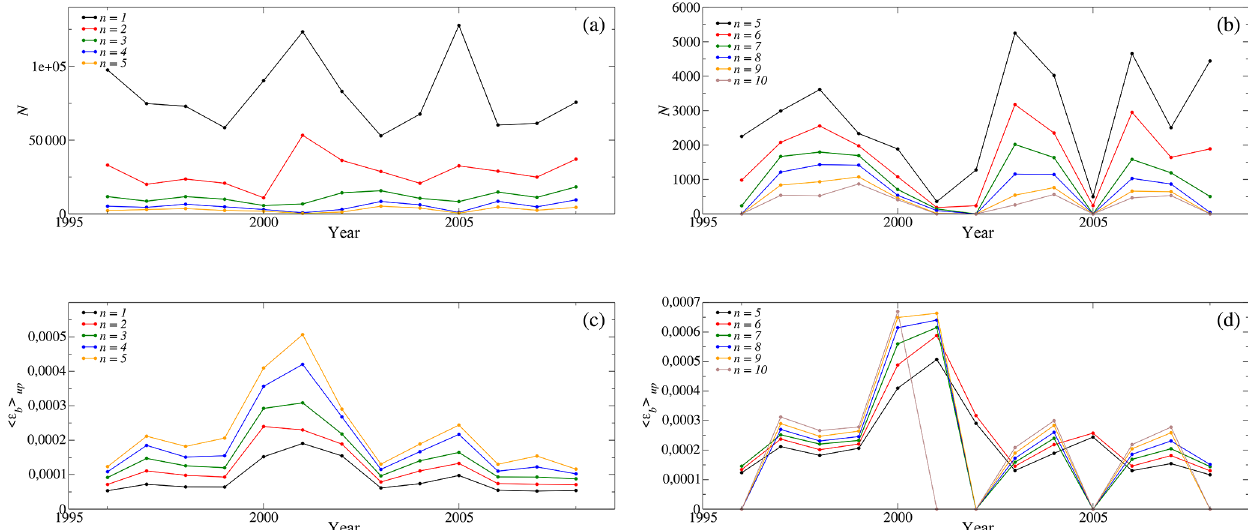
Figure 4. N and (cid:104) (cid:15) b (cid:105) up calculated from the 13 time series of µ(t) for different values of n . For clarity, separate plots are shown for two sets of values for n : from 0 to 5 (a, c) , and from 5 to 10 (b, d) . The grey region corresponds to years of maximum solar activity, as described in the